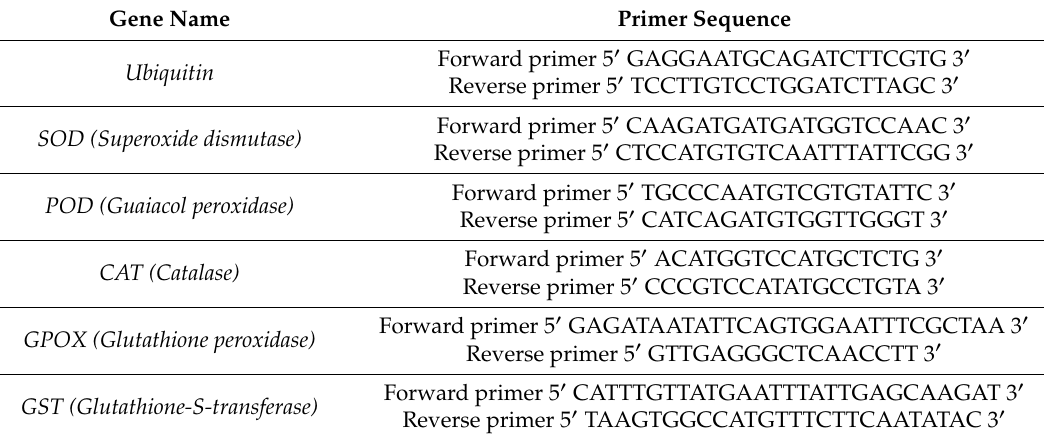
Table 1. Primers used for qRT-PCR analysis in the present